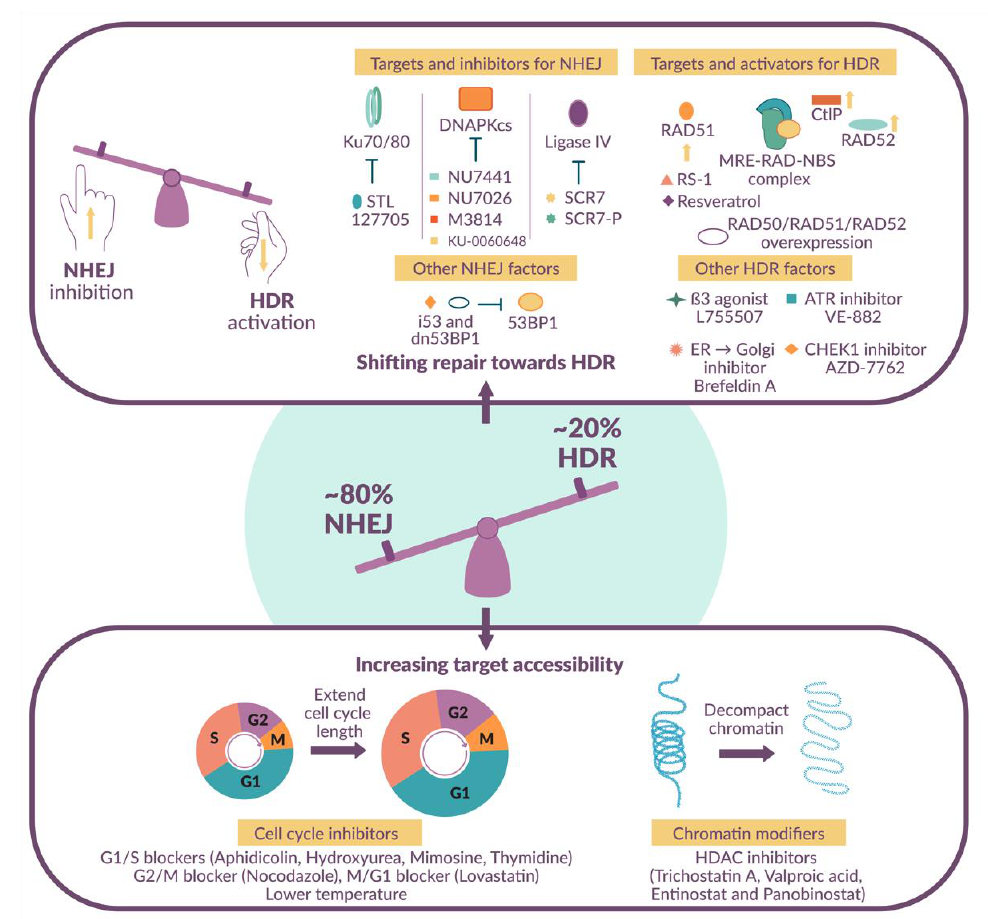
Figure 2. Approaches for enhancing precision editing. Manipulations that favor HDR over NHEJ or which increase the accessibility of the genomic target can increase editing efficacy. which increase the accessibility of the genomic target can increase editing